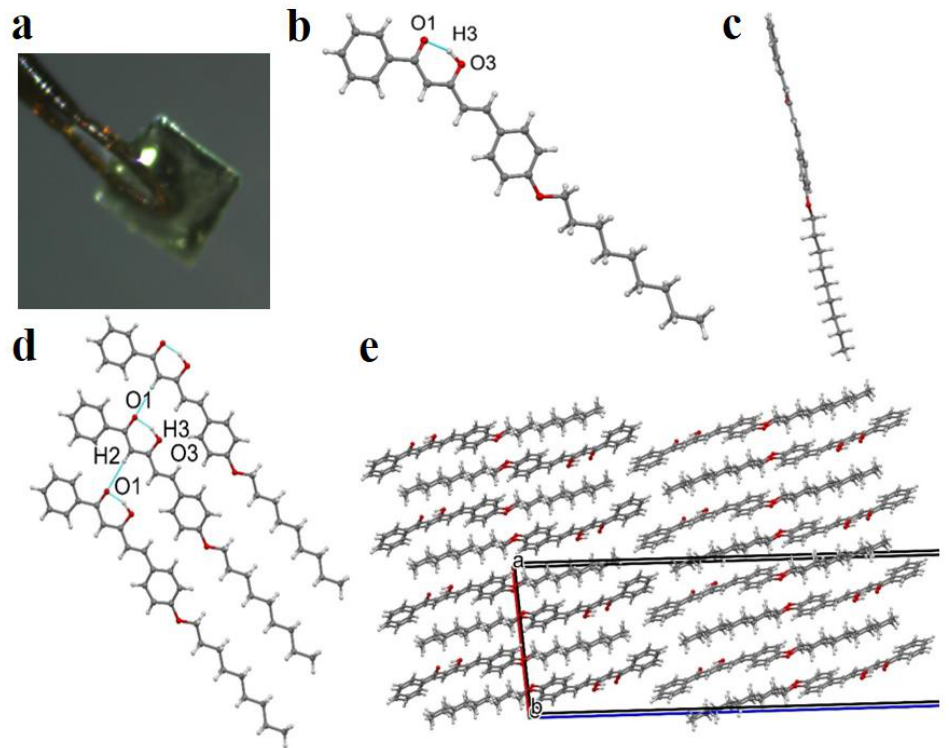
Figure 1. ( a ) Photo of the single crystal of HCur ; ( b , c ) ORTEP view of two projections of the molecule in the crystal. Non-hydrogen atoms are represented by probability ellipsoids of thermal vibrations ( p = 50%), hydrogen atoms by spheres of arbitrary radii. ( d ) O- H…O and C- H…O hydrogen bonds (blue dashed lines) in the crystal 3 ; ( e ) molecular packing fragment in the crystal 3, hydrogen atoms are not shown for clarity.